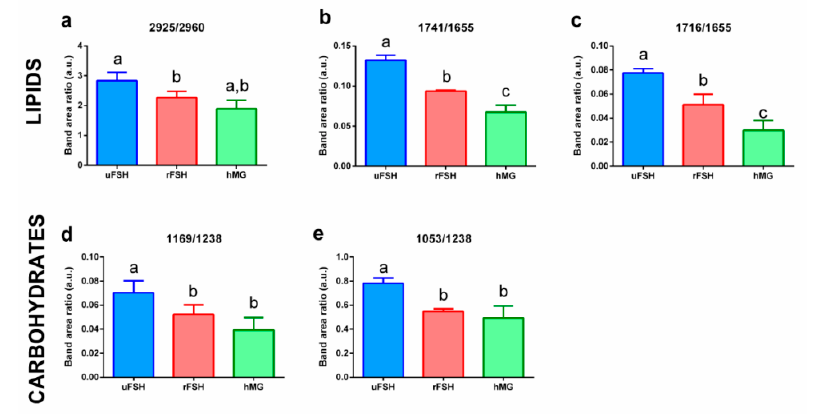
Figure 8. Results of ANOVA test on band area ratios 2925 / 2960 ( a ), 1741 / 1655 ( b ), 1716 / 1655 ( c ), 1169 / 1238 ( d ), 1053 / 1238 ( e ). Histograms show the values of the 5 most discriminant band area ratios obtained by peak fitting procedure on mean spectra and mean ± standard deviation spectra of the uFSH, rFSH and hMG experimental groups. Data are reported as mean ± standard deviation. Di ff erent letters above histograms indicate a statistically significant di ff erence among groups. Statistical significance was set at p < 0.05 and calculated by ANOVA followed by Tukey’s multiple comparisons test.